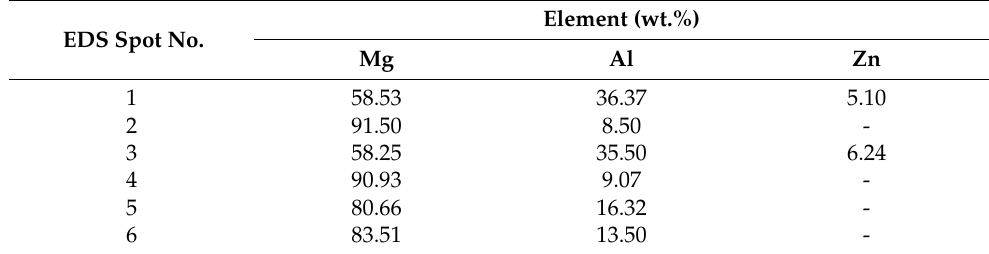
Table 2. Microanalysis of the chemical composition.